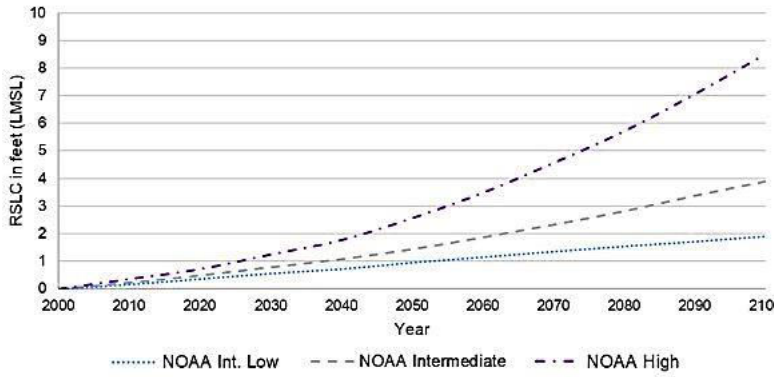
Figure 3 Projected scenarios of relative sea-level change for St. Petersburg, Florida (USACE